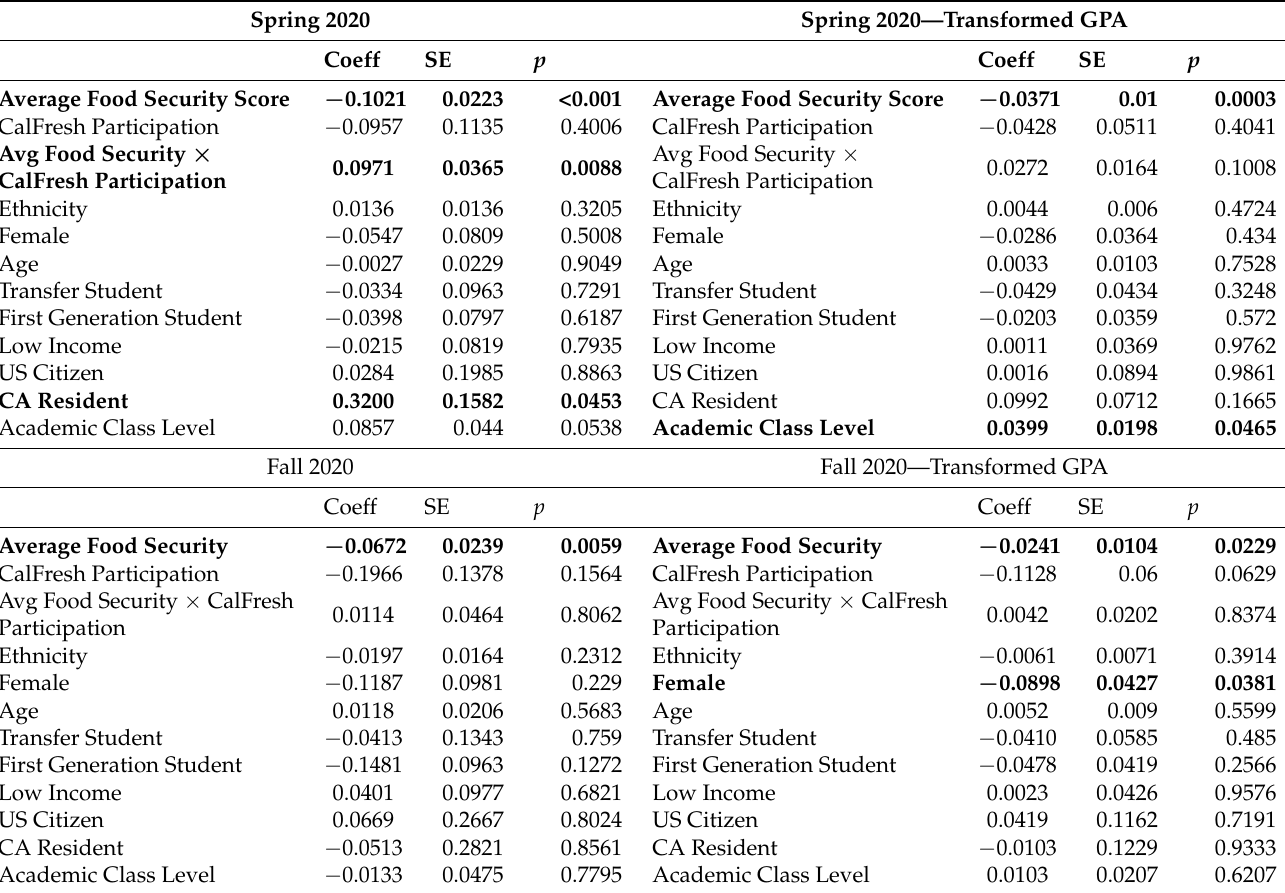
Table 2. Full Moderation Model: Food Security Scores’ Effect on Quarter GPA with CalFresh